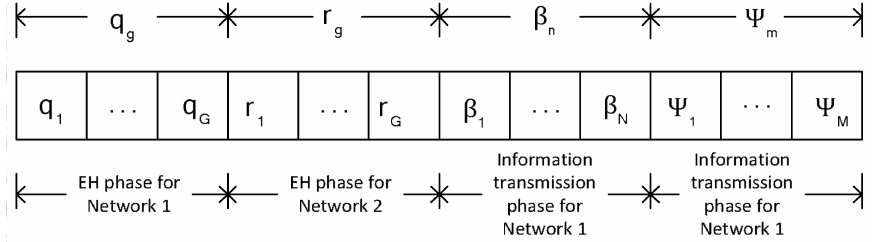
Figure 2. Proposed energy harvesting and information-transmission time-division multiple access (TDMA)